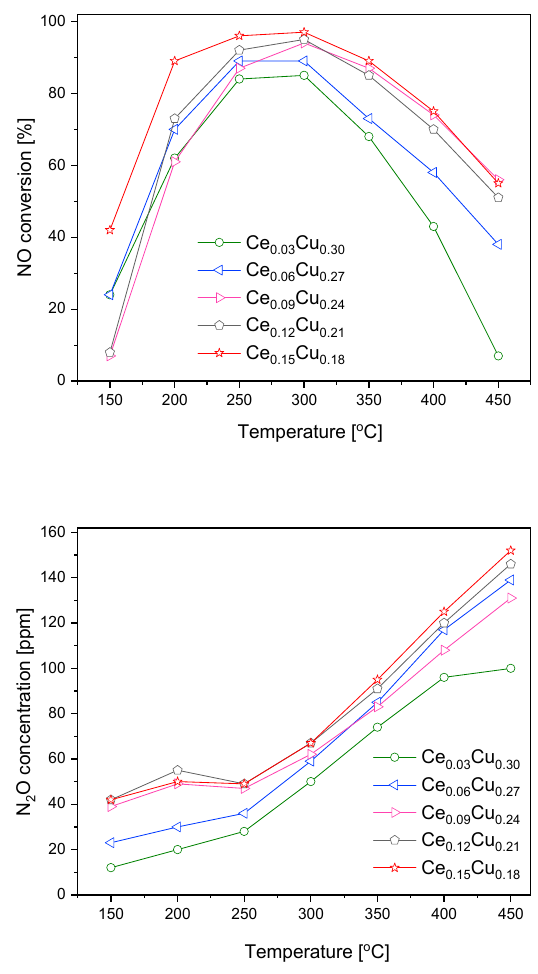
Figure 3. NO conversion and N 2 O formation over Cu–Al catalysts doped with cerium.